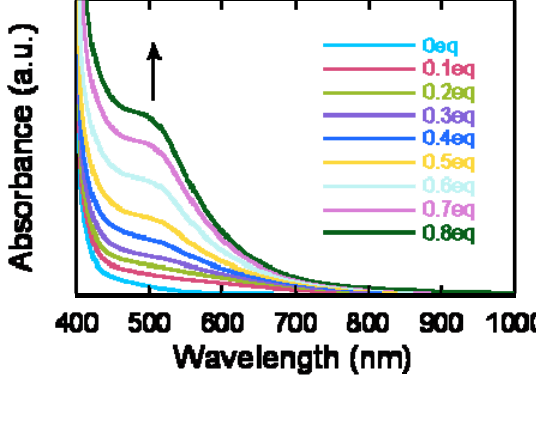
Figure 1. UV-Vis titration experiments of P1 in 1,2-dichlorobenzene with a TCNE solution in 1,2-dichloroethane at 100 °C. Reaction completion was confirmed by time-dependent